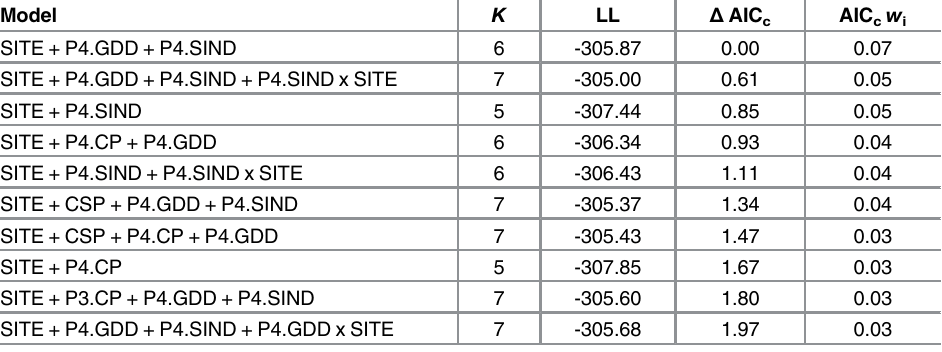
Table 2. Model selection results for the top ten models for chicks per hen at Mt. Evans and Trail Ridge at Rocky Mountain National Park in Colorado, USA. Number of parameters ( K ), negative log likelihood (LL), difference between the best model and given model ( Δ AIC c ), and AIC c weights ( w i ) are provided. Covari- ates shown include study site (SITE), cumulative precipitation in spring (P1.CP) and brood-rearing period (P4.CP), brood-period seasonal index (P4.SIND), brood-period number of growing degree days (P4.GDD), and brood-period cumulative precipitation (P4.CP).